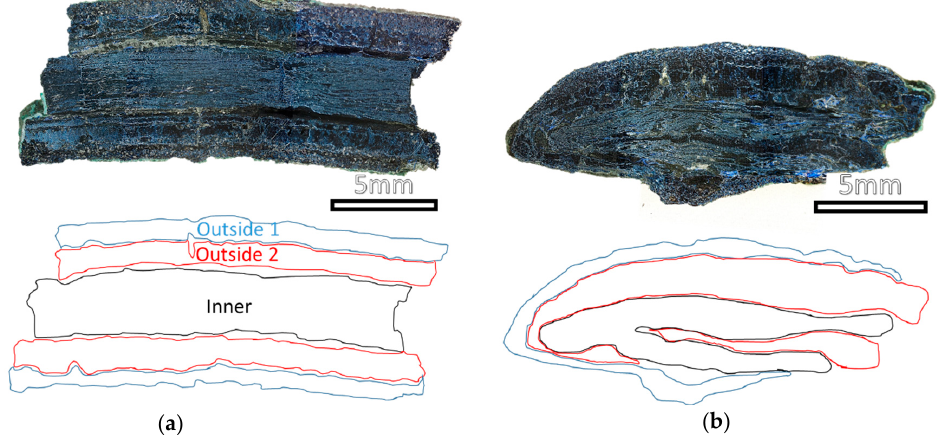
Figure 4. Images acquired with the USB digital microscope and hand draw scheme of the cross- sections of ( a ) tip and ( b ) head of the nail. The layers were drawn by following the borders of the area with different aspects; the same colour was used for areas with similar characteristics in the two samples.